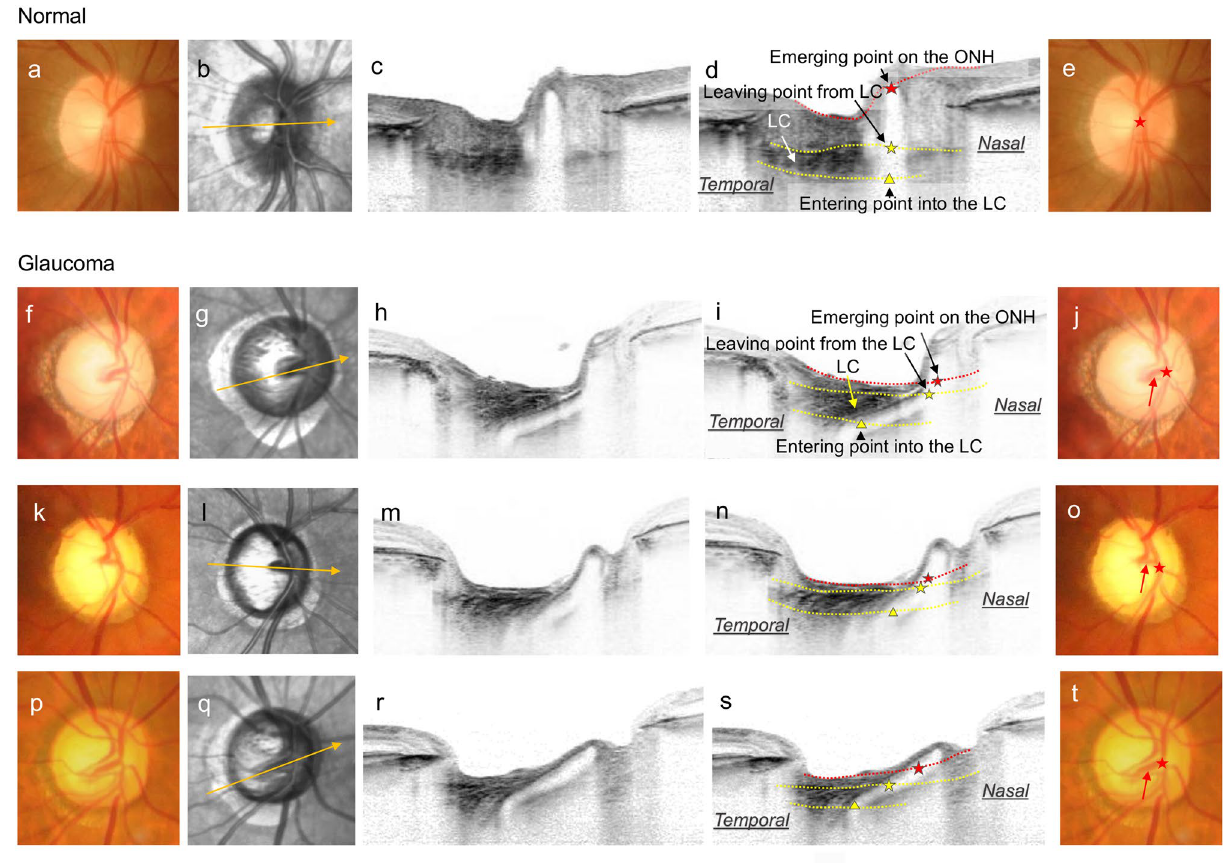
Figure 3. Spectral-domain optical coherence tomography (SD-OCT) of the optic nerve head (ONH) showing the path of the central retinal vessel (CRV) through the lamina cribrosa (LC). ( a–e ) Normal eye. ( a ) Fundus photograph. ( b ) Infrared fundus image with the SD-OCT scan line (orange arrow). ( c ) SD-OCT B-scan image obtained at the line shown in ( c ). ( d ) The same image as ( c ) but with labels. The red dashed line shows the surface of the ONH and the red star shows the point where the CRV emerges on it. The yellow star indicates the point where the CRV leaves the LC, and the yellow triangle indicates the point where it enters the LC from retrolaminar ONH region. In normal eyes, the CRV takes an almost perpendicular path through the LC. ( e ) Same image as ( a ) but with labels. The position of the CRV on the ONH (red star) was identical to the point of CRV emergence onto the ONH, identified in d (red star). ( F–t ) Glaucomatous eyes. ( f, k, p ) Fundus photographs. ( g, l, q ) Infrared fundus images of f , k , p , respectively, with the OCT scan lines (orange arrows). ( h, m, r ) SD-OCT images of the ONH that captured the path of the CRV through the LC obtained at the scan lines shown in ( g , l , q ), respectively. ( i, n, s ) The same images as ( h , m , and r ), respectively, but with the same labels as those used in ( d ). In eyes with glaucoma, the CRV takes an angled path through the LC toward the nasal direction and emerges on the ONH surface at its nasal area. The CRV and surrounding laminar pores showed similar angles and exhibited parallel alignment as if they deformed simultaneously. ( j, o, t) Same images as ( f , k , and p ), respectively, but with labels. The nasal position of the CRV on the ONH (red star) is identical to the point of CRV emergence onto the ONH surface identified in the OCT B-scan. The nasally angled path of the CRV within the LC is observed in the fundus photograph as a traversing vessel on the ONH (red